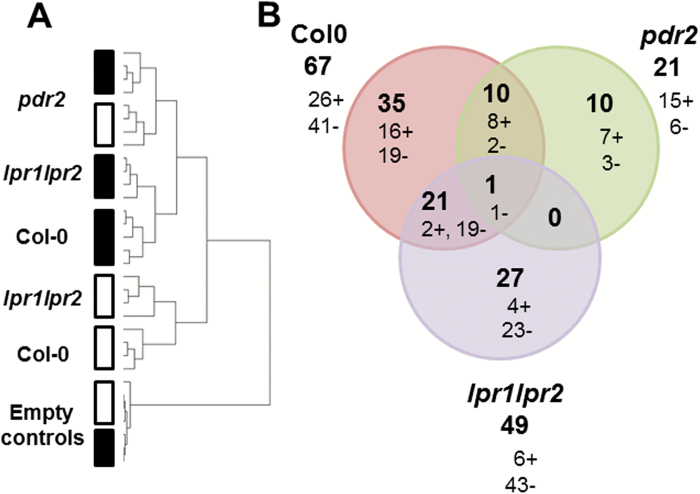
(A) Sample tree of hierarchical cluster analysis (Pearson correlation, average linkage) after two-factor ANOVA (factor assignments: genotype and treatment; P<0.05) for the non-targeted metabolite profiling datasets from experiment 3. White and black boxes denote +Pi (2.5mM) and –Pi (no Pi added) treatments, respectively. (B) Venn diagram showing the total number of differential features in root exudates for each genotype after +Pi (2.5mM) and –Pi (no Pi added) treatment and the number of overlapping features, as well as the number of genotype-specific features. The + and – signs after each number refer to higher intensities under +Pi and –Pi conditions, respectively. The numbers represent the overlaps between all three independent experiments. (This figure is available in color at JXB online.)